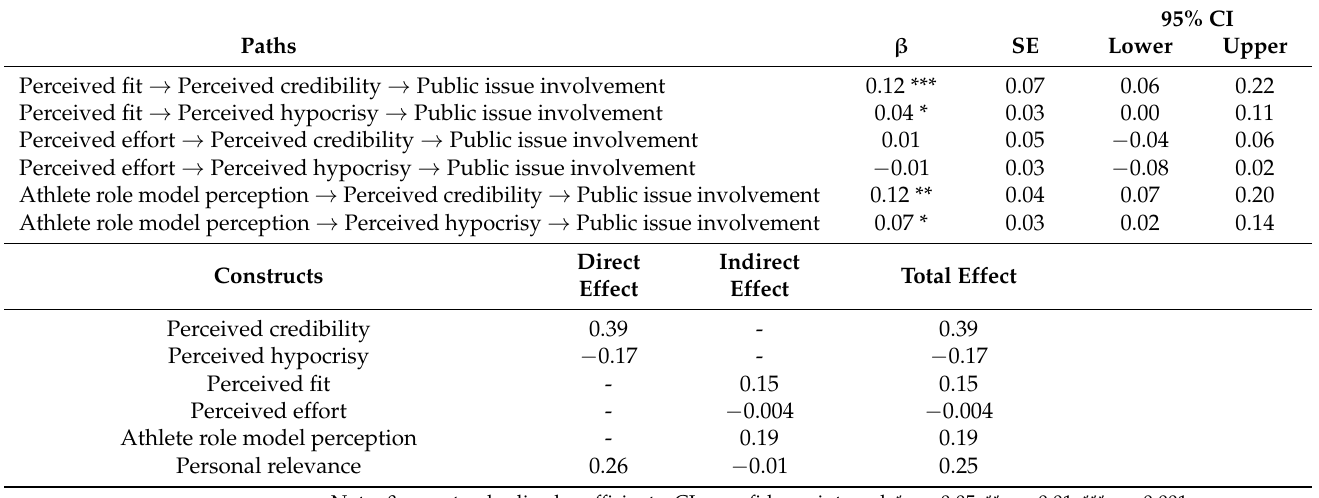
Table 5. Results of mediation analyses (Sample B: n =